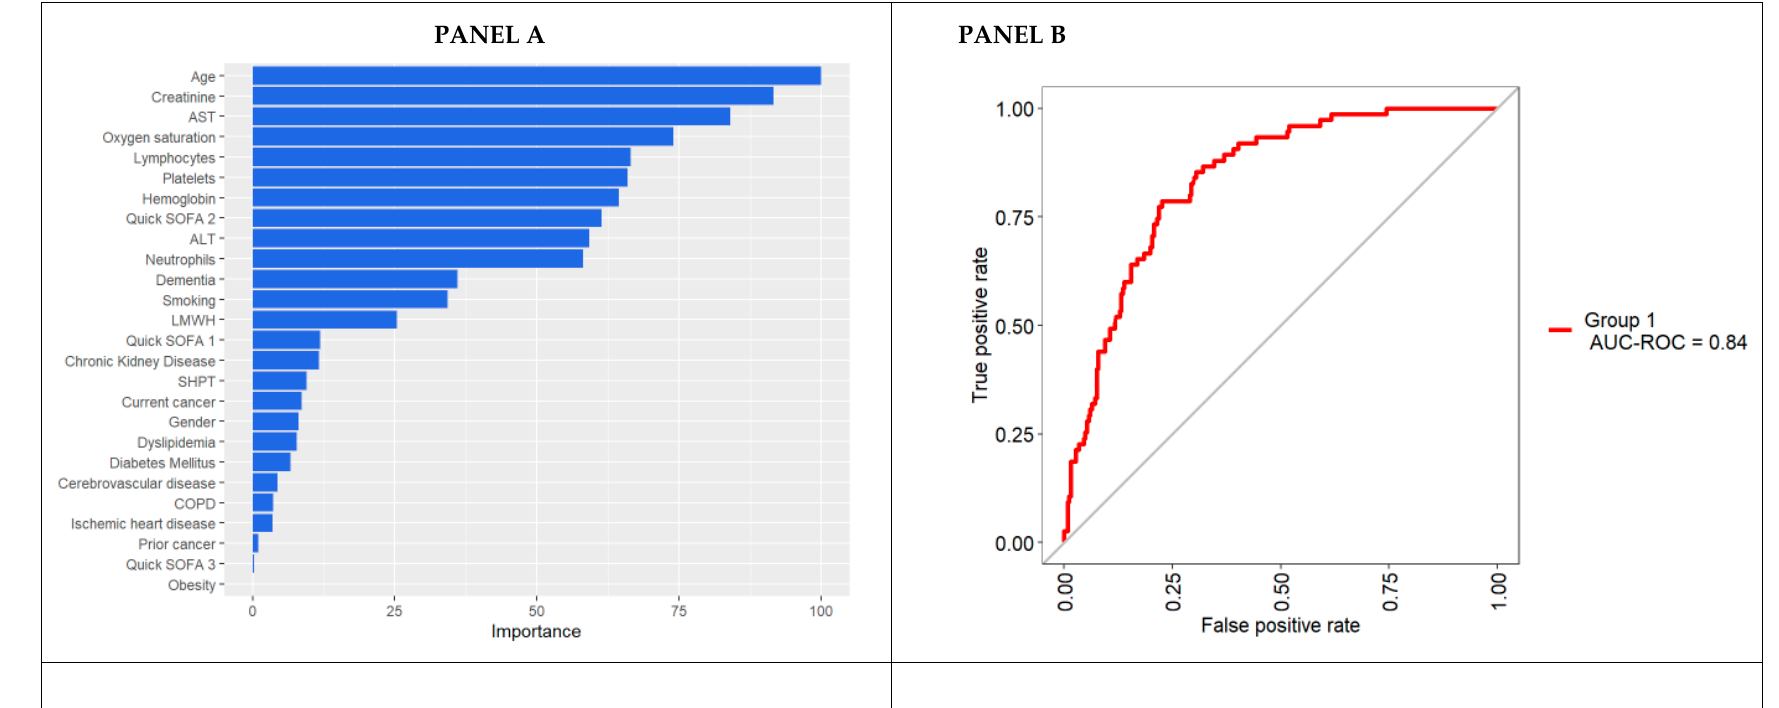
Figure 2. Random Forest’s variable importance plot ( Panel A ) and ROC curve on the Random Forest predictions ( Panel B ). The median resampled accuracy is 0.86.